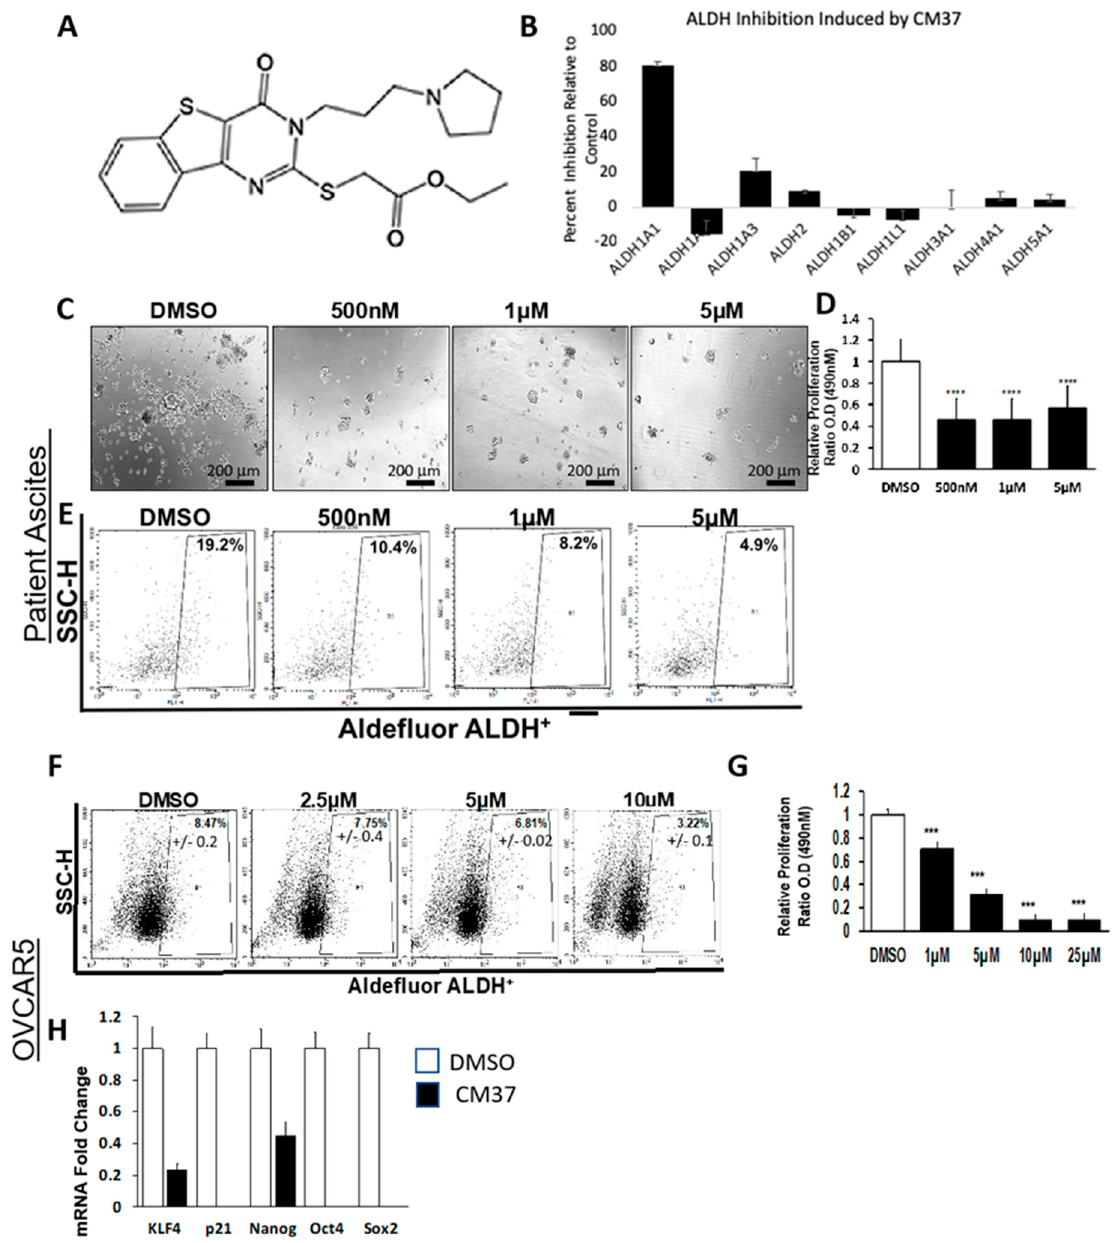
Figure 1. Effects of CM37 on ovarian cancer (OC) sphere formation and stemness markers. ( A ) The chemical structure of CM37; ( B ) percent inhibition of aldehyde-dehydrogenase (ALDH) enzymatic activity by 20 µ M CM37 measured in vitro for the different orthologues; ( C ) spheres derived from primary OC cells isolated from ascites fluid and treated with control or increasing doses of CM37 were photographed with an inverted microscope at 100 × magnification. ( D ) Numbers of live cells growing as spheres were assessed by CCK-8 colorimetric assay in patient-derived OC cells. ( E ) Percentage of ALDH+ cells in untreated/or CM37-treated (500 nM–5 µ M) patient-derived OC cells. ( F ) Percentage of ALDH+ cells in untreated/or CM37-treated (2.5–10 µ M) OVCAR5 cells. ( G ) OVCAR5 cells were plated under low attachment conditions for six days; numbers of live cells were assessed by using the CCK8 colorimetric assay. ( H ) Relative expression of stem cell markers KLF4 , Nanog , Oct4 , Sox2 as measured by qRT-PCR in ALDH+ FACS-sorted OVCAR5 cells treated with CM37 (1 µ M) for 24 h. Bars represent averages of triplicate measurements; **** corresponds to p < 0.0001; *** corresponds to p < 0.001.